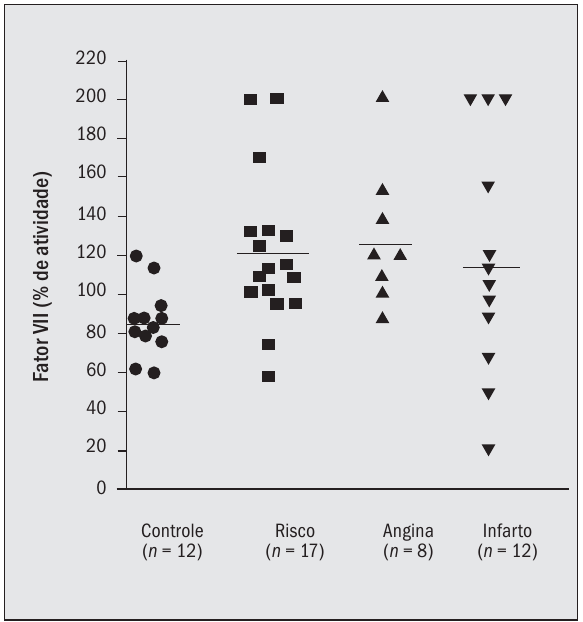
Figura 2 – Resultados da determinação da atividade do fator VII nos quatro grupos estudados ( n = número de amostras). As barras horizontais indicam os valores médios encontrados para cada grupo. Nenhuma diferença foi encontrada entre as médias dos grupos